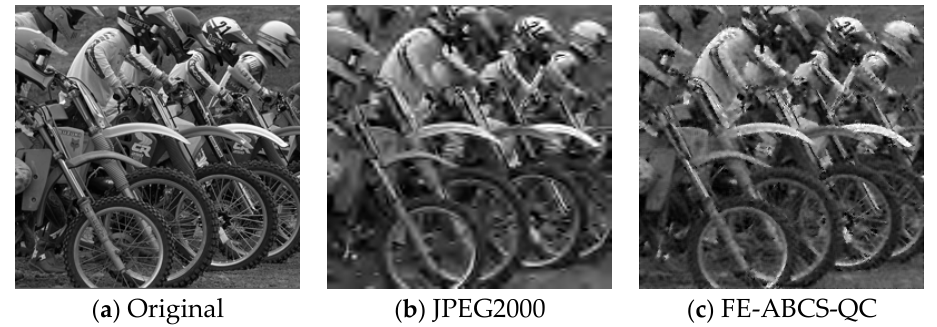
Figure 13. The two algorithms’ comparison of test image Bikes at the condition of bpp = 0.25: ( a ) original image, ( b ) JPEG2000 image (PSNR = 29.80, SSIM = 0.9069, GMSD = 0.1964), ( c ) image by the FE-ABCS-QC algorithm (PSNR = 30.50, SSIM = 0.9366, GMSD = 0.1574).